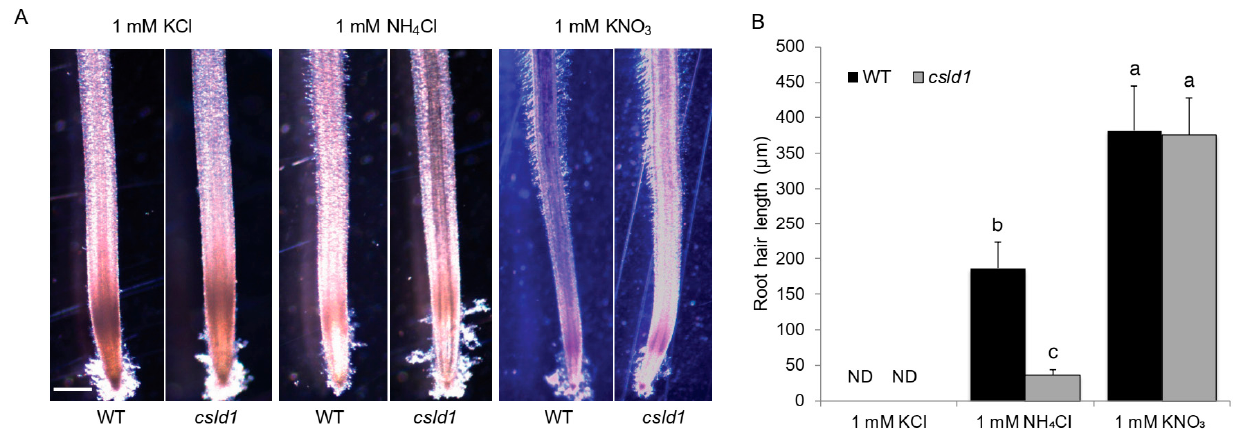
Figure 4. CSLD1 promotes root hair elongation in the presence of NH 4+ . ( A ) Seminal roots of wild- type and csld1 mutants grown in 1 mM KCl, KNO 3 , and NH 4 NO 3 and ( B ) quantification of root hair length. Scale bars = 500 µ m. Bar graph show mean values ± standard error of means ( n = 8). Different letters indicate significant differences between groups according to Tukey’s HSD test ( p < 0.05).